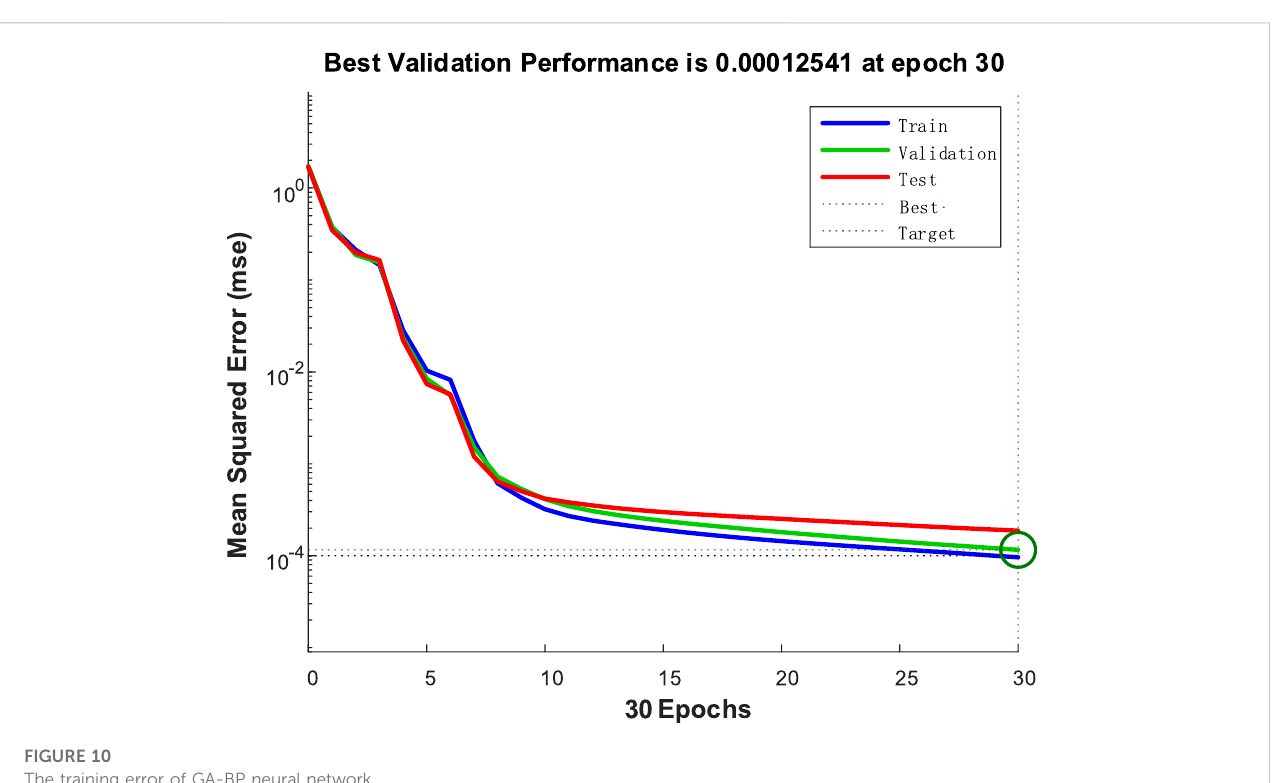
FIGURE 10 The training error of GA-BP neural